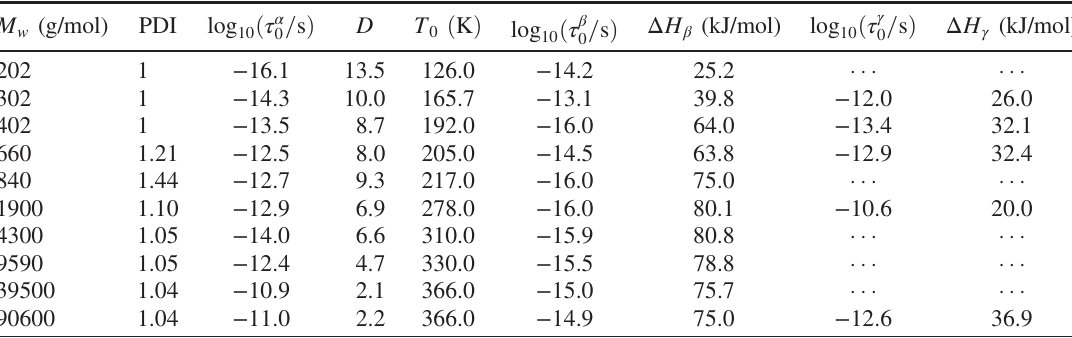
VII. Weight-averaged molecular weight M number-averaged molecular weight), fit parameters from VFT fits of τ α data to τ α ¼ τ α 0 exp DT 0 = ð T − T 0 Þ , and fit parameters from Arrhenius fits of τ β and τ γ data to τ β ¼ τ β 0 exp Δ H β =RT , for the PMMA data in Fig.